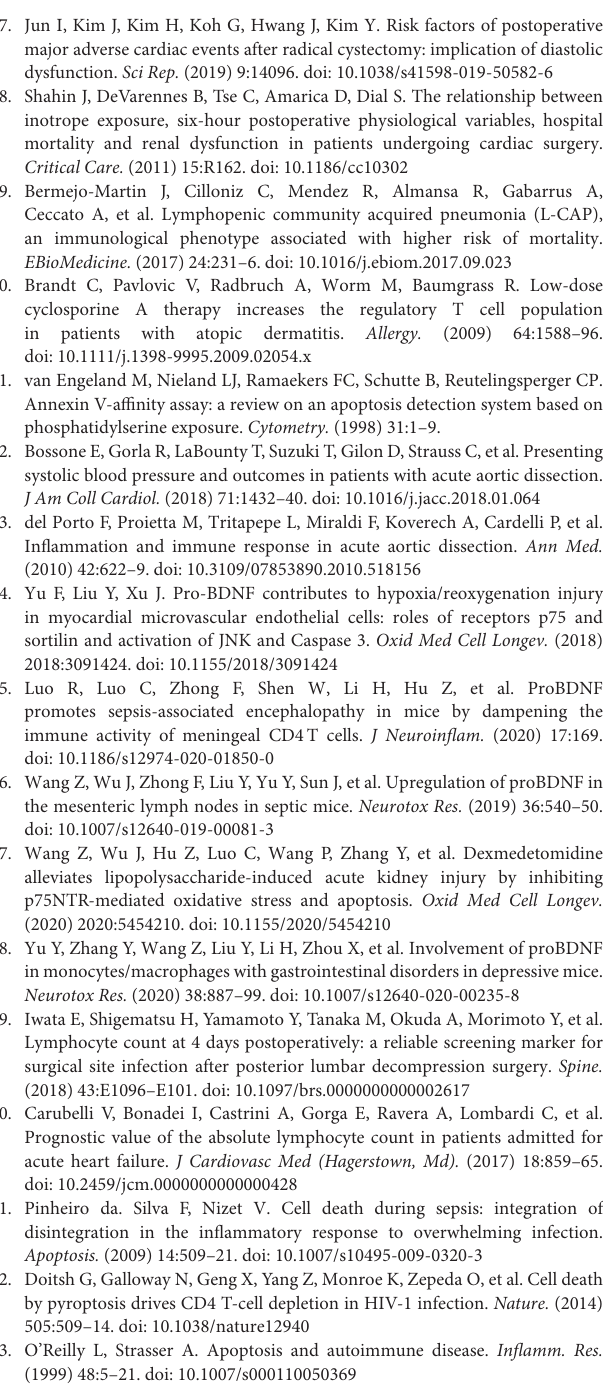
postoperative outcomes in AAD patients in the prospective cohorts. AUC, the area under the curve; CI, confidence interval. Supplementary Table 1 | Baseline data of the enrolled AAD patients and control donors. Supplementary Table 2 | Baseline characteristics of patients with MAE and No MAE in prospective